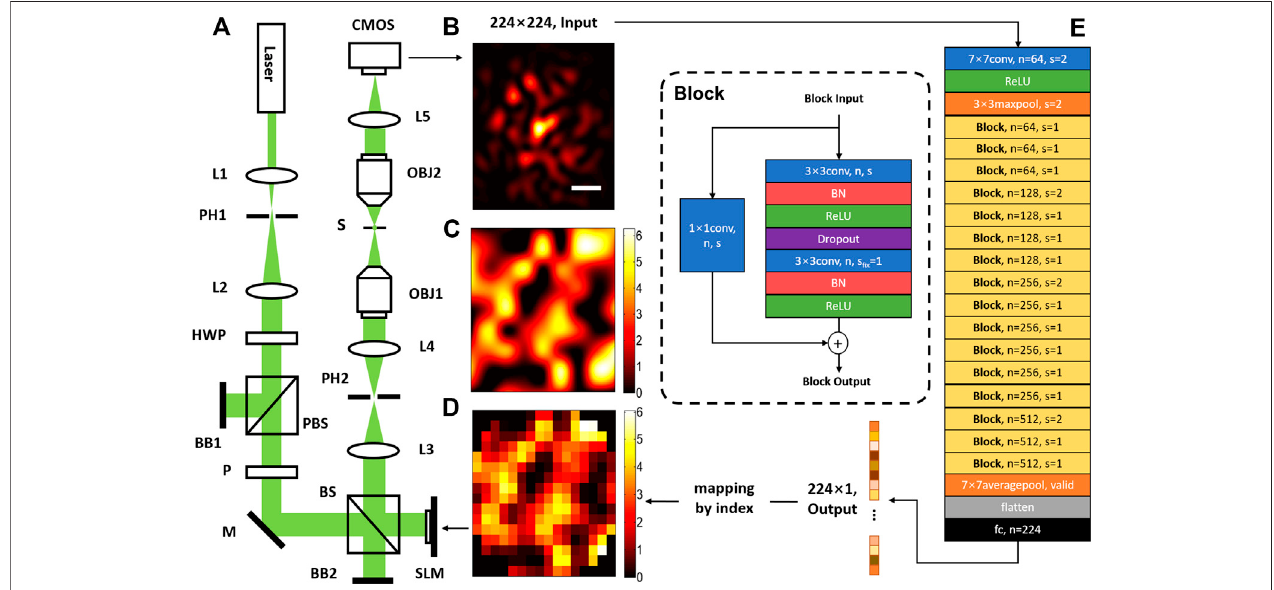
FIGURE 1 | The schematic diagram of DLZAC. (A) An optical system for DLZAC: L1-L5, lens; PH1-PH2, pinhole; HWP, half-wave plate; PBS, polarized beam splitter; BB1-BB2, beam block; P, linear polarizer plate; M, mirror; BS, beam splitter, 50:50 (R:T); SLM(256 × 256), spatial light modulator; OBJ1-OBJ2, objective lens (Nikon,20X/0.75NA);S,sampleplane;CMOS,complementarymetaloxidesemiconductorcamera. (B) The224 × 224inputPSFimage(scalebar:1 μ m). (C) Thephase mask. (D) The correction pattern. (E) The architecture of the DL